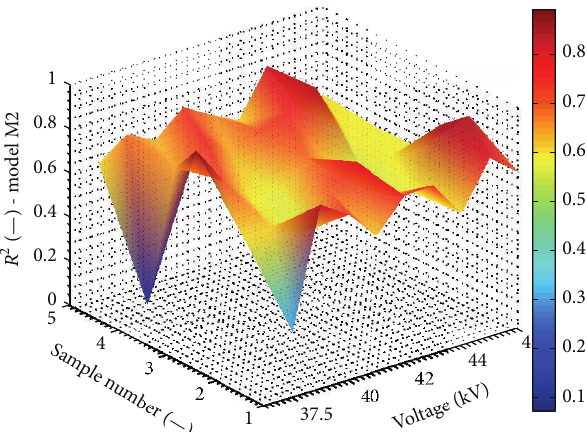
Figure 19: Comparison of 𝑅 2 coefficient obtained by regression of model M2 for all the recorded signals.